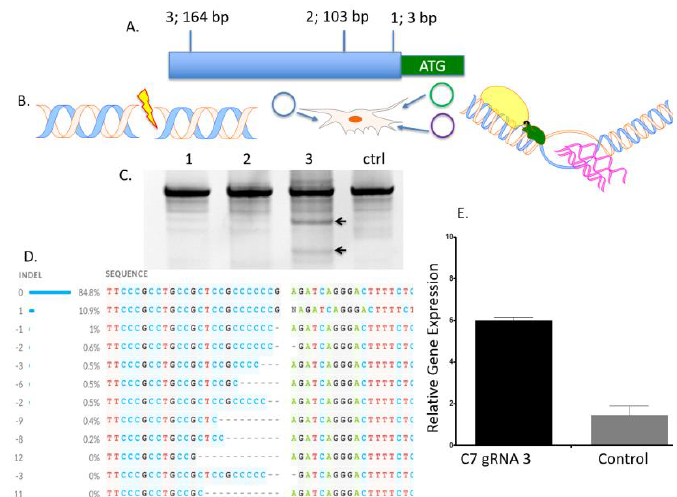
Figure 1. COL7A1 promoter targeting and transcriptional activation. ( A ) Three guide RNAs in the COL7A1 promoter were generated and their distance from the initiating methionine is